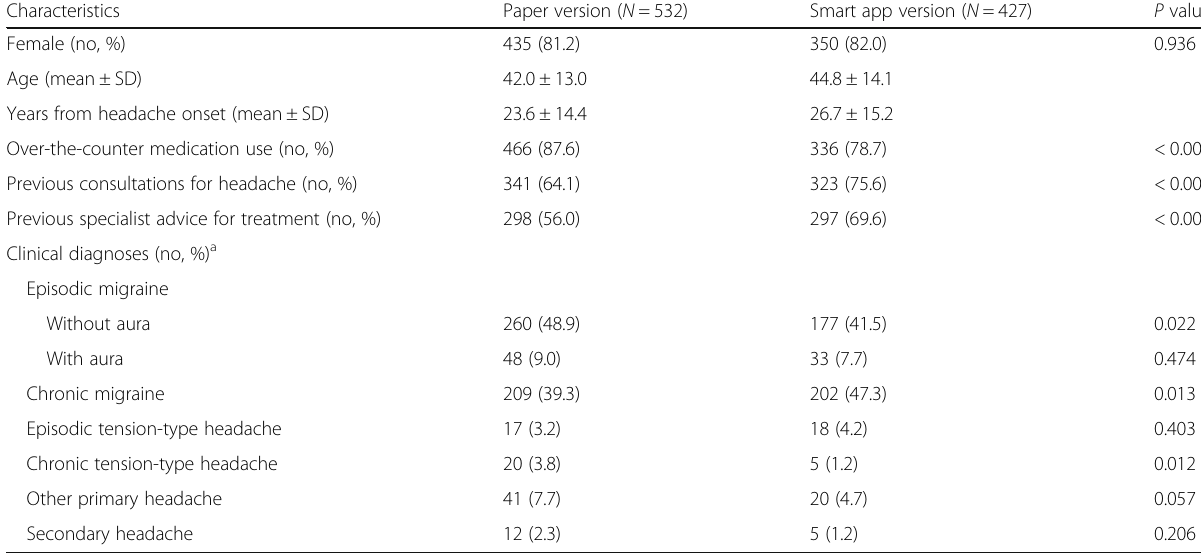
Table 2 Clinical data of the included subjects Characteristics